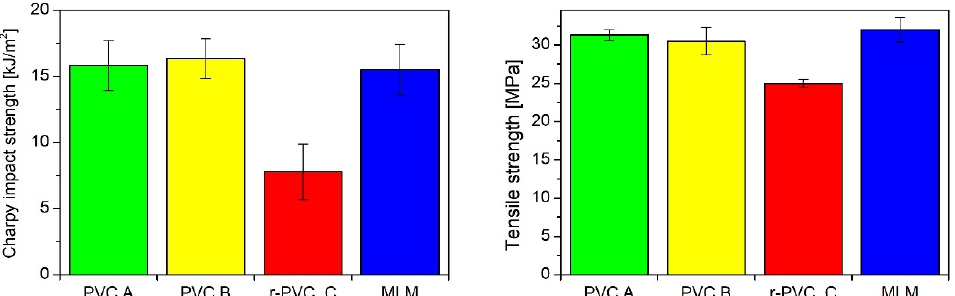
Figure 5. Comparison of the mechanical properties of recycled PVC (C) and non-recycled PVC (A,B) with the multi-layer material made of them (MLM) (errors bars represent standard deviation).